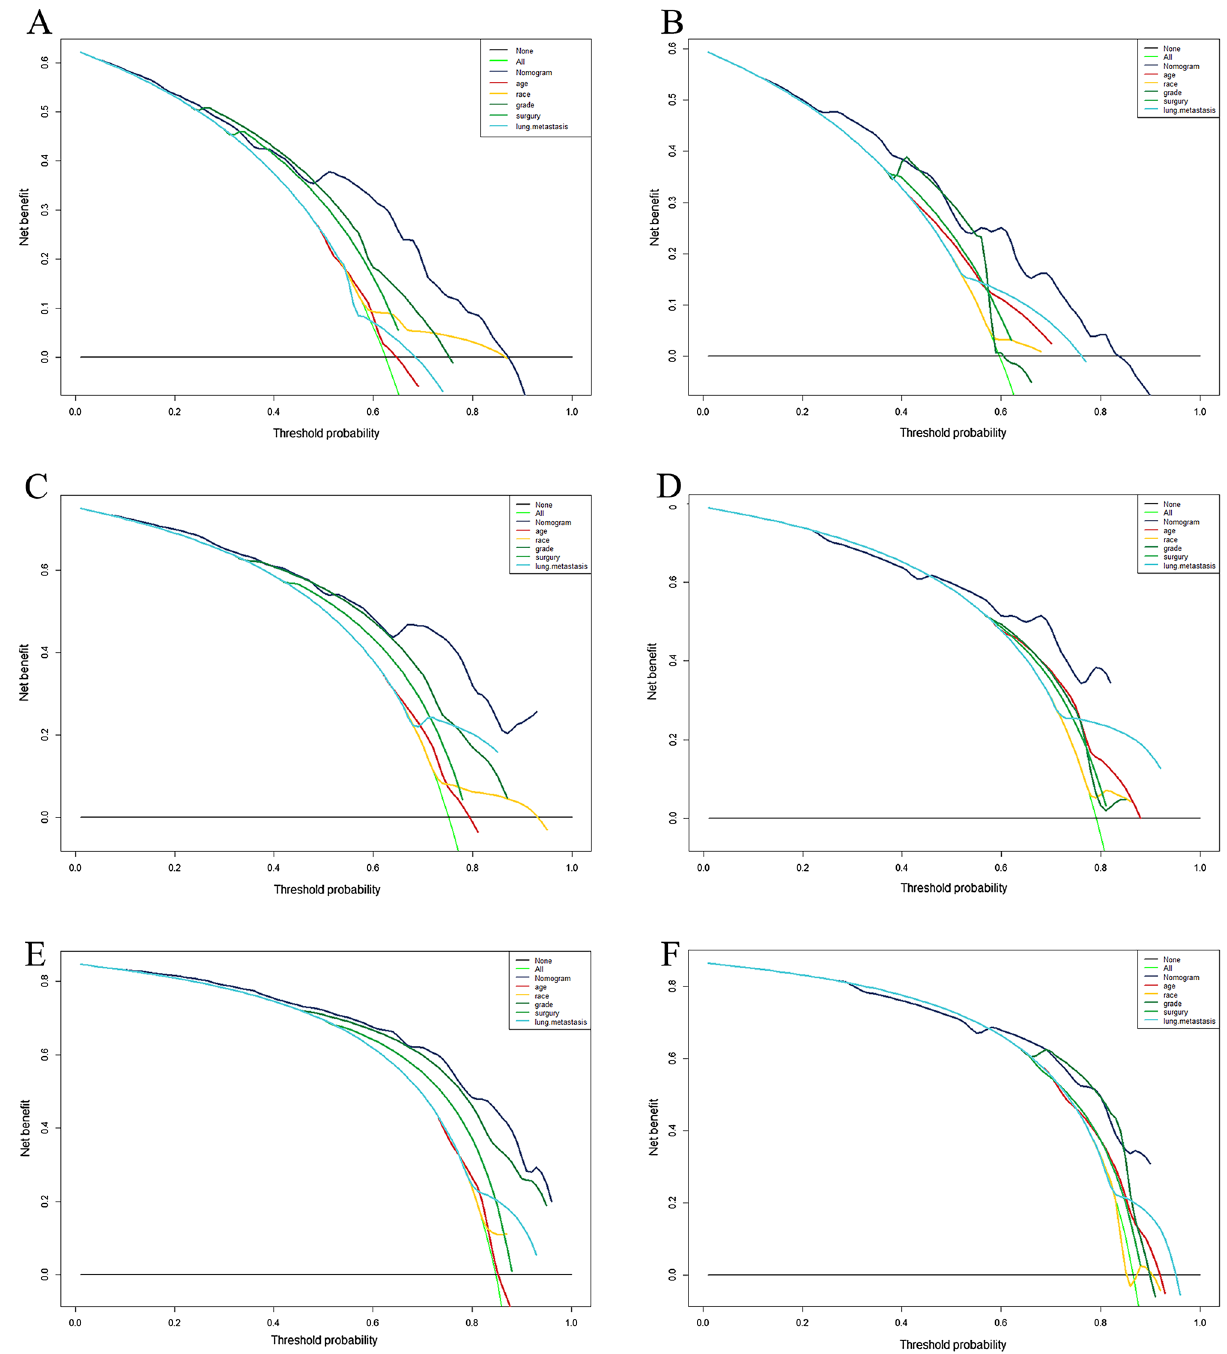
Figure 7. Comparison of decision curve analysis between the prognostic nomogram and single independent factors. 6-month survival in the training set ( A ); 12-month survival in the training set ( C ); 18-years survival in the training set ( E ); 6-month survival in the validation set ( B ); 12-month survival in the validation set ( D) ; 18-years survival in the validation set ( F